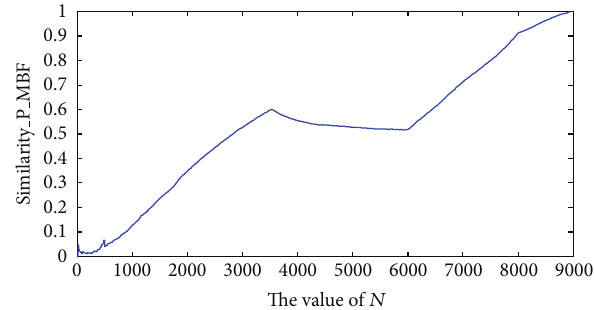
Figure12:VIPratiosintop 𝑁